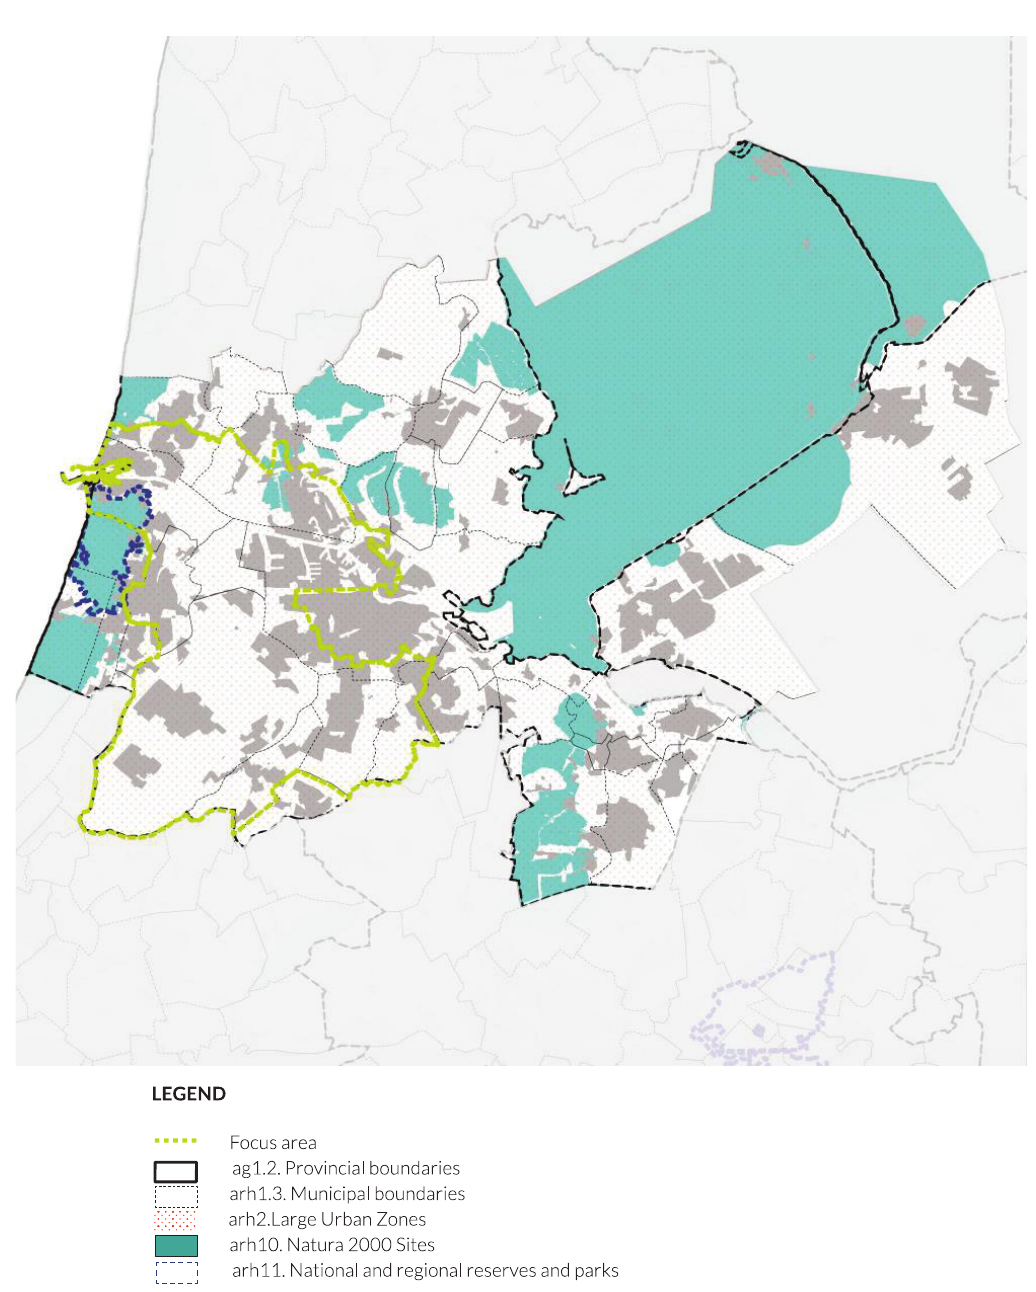
Figure 3. Administrative, demographic and planning issues. Pilot case of Amsterdam. Source: REPAiR (2018c); map by REPAiR TUDelft